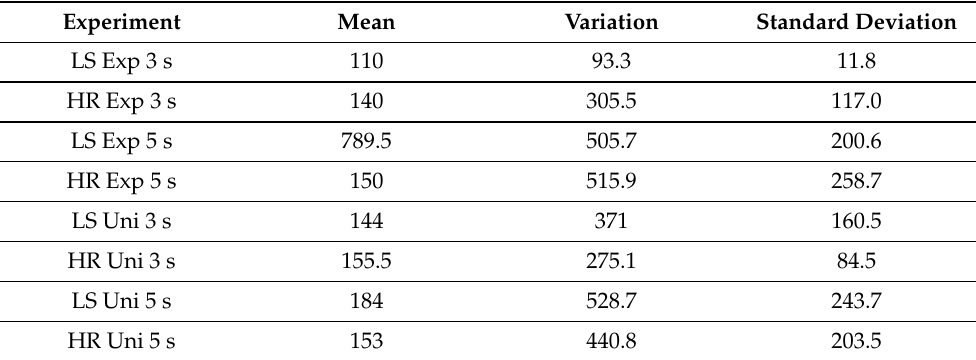
Table 6. Experiment latency statistical